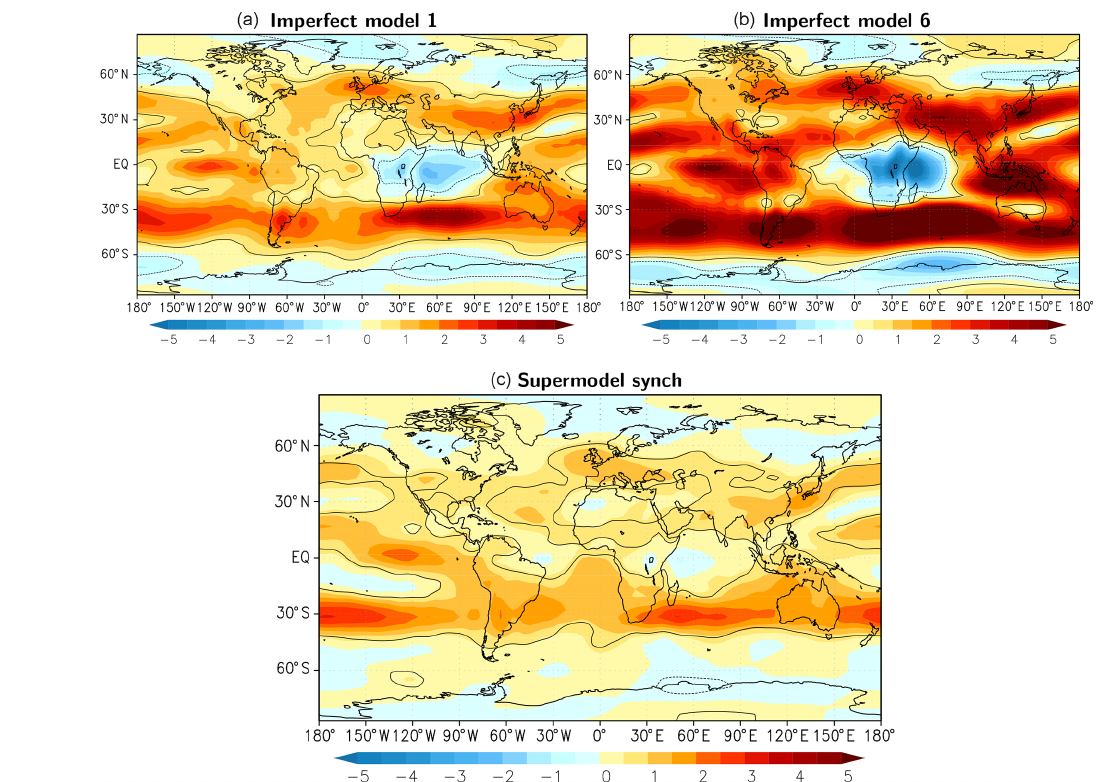
Figure 13. Difference in the east–west component of the wind at the 200hPa pressure level averaged over model years 2011–2040 for the various models with respect to the truth. Contours denote areas where the difference is larger than the sampling error at 95% confidence (solid for positive difference; dotted for negative). Positive values imply stronger mean winds blowing eastward. Units: ms − 1 .